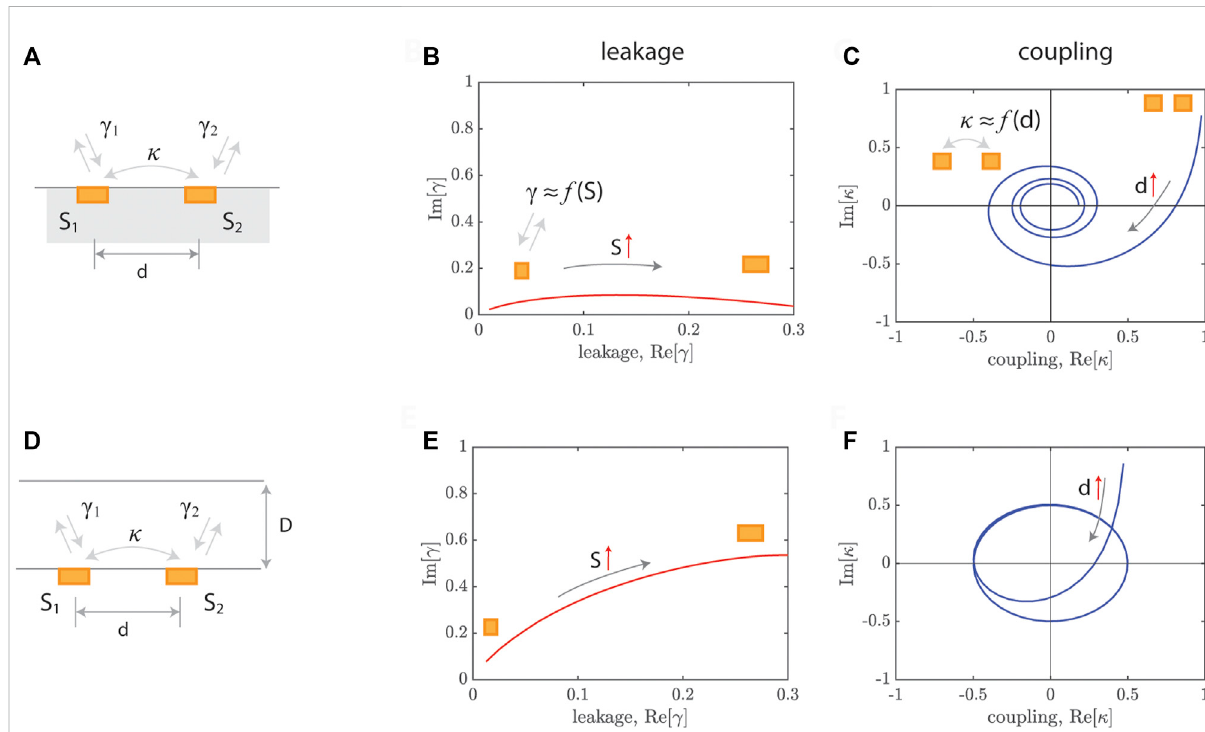
FIGURE 3 Physicalunderstandingofleakageandcouplingrate. (A) Coupledresonatorinafree fi eld. (B) Leakageratefordifferentsizes( S )inafree fi eld[11]. (C) Couplingratefordifferentdistances( d )inafree fi eld[11]. (D) Coupledresonatorinawaveguide. (E) Leakagerateinawaveguide. (F) Couplingrate in a waveguide. The gray arrows indicate the increase in s and d